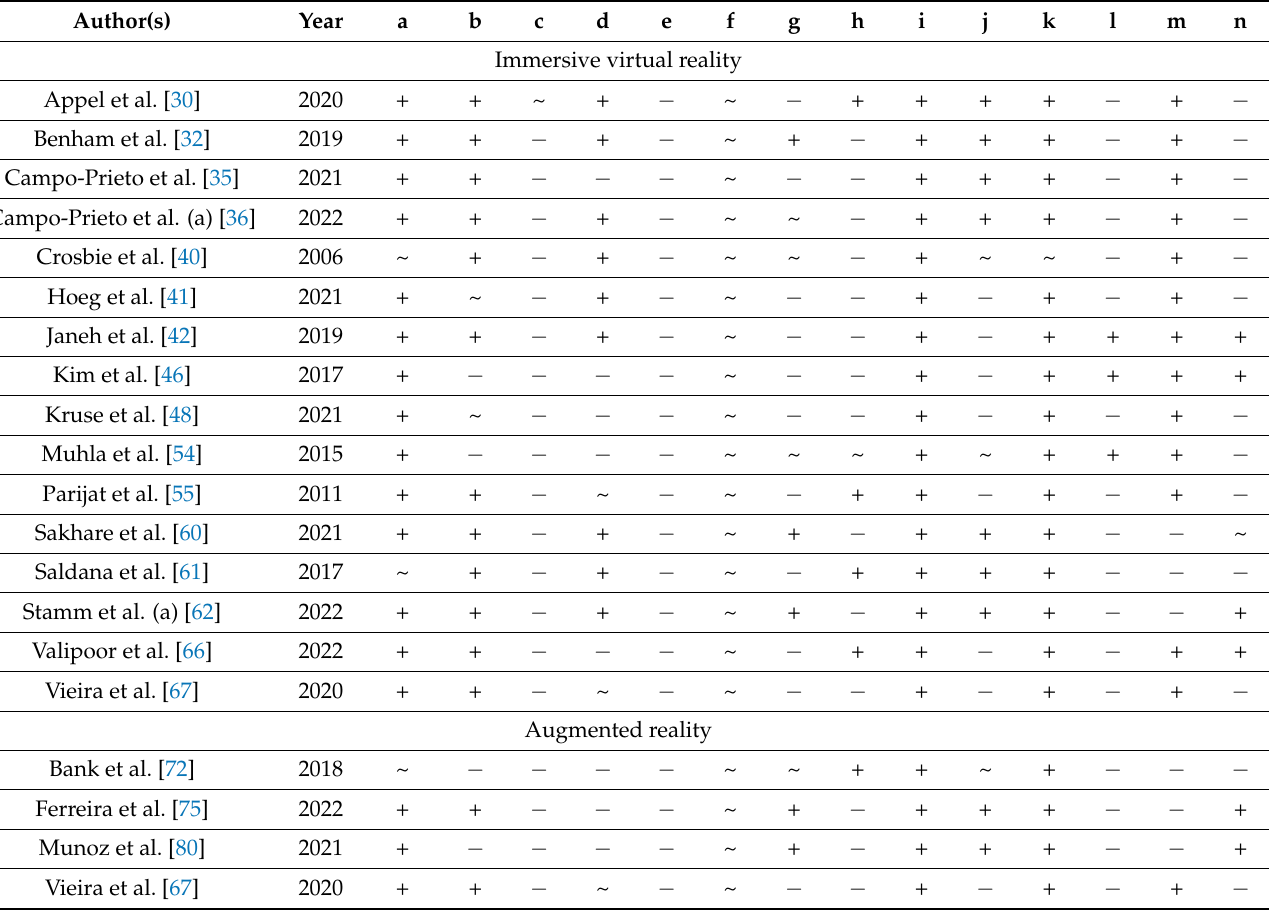
Table 3. NIH Quality Assessment